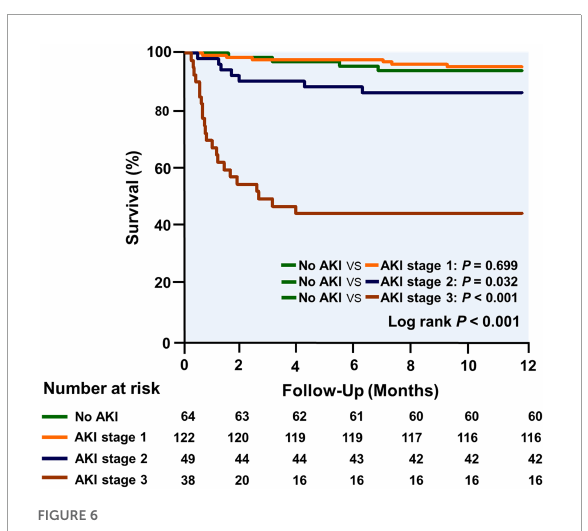
FIGURE6 The Kaplan–Meier curves for survival analysis are stratified by AKI stage during the first year after